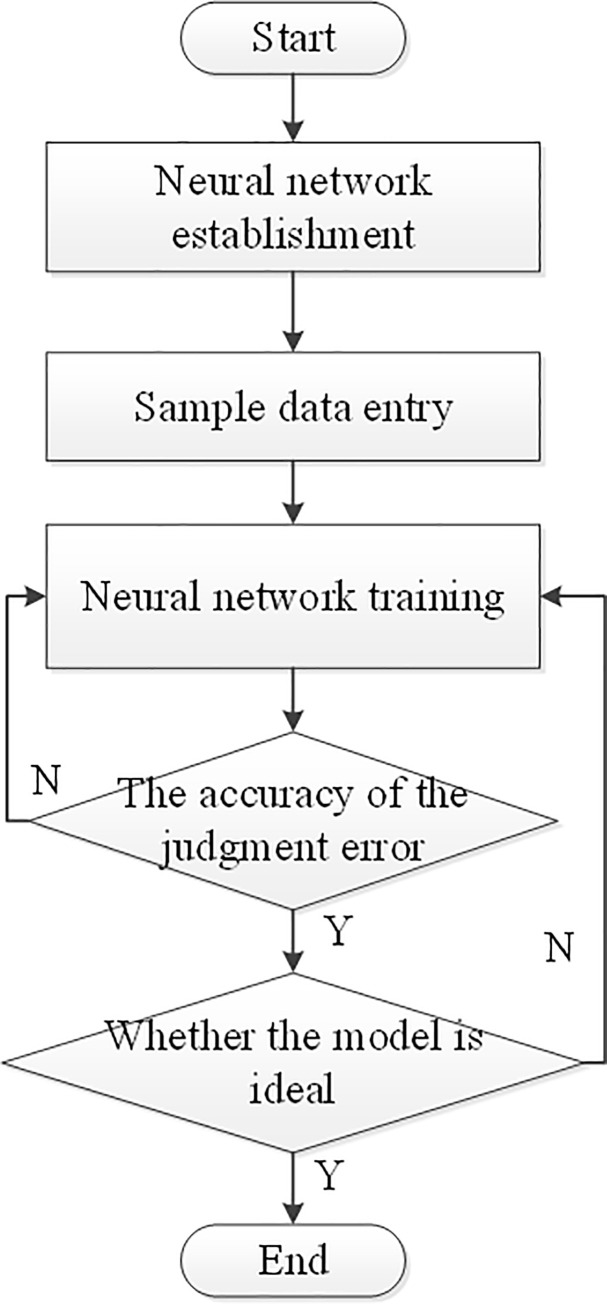
Neural network model training flow chart.